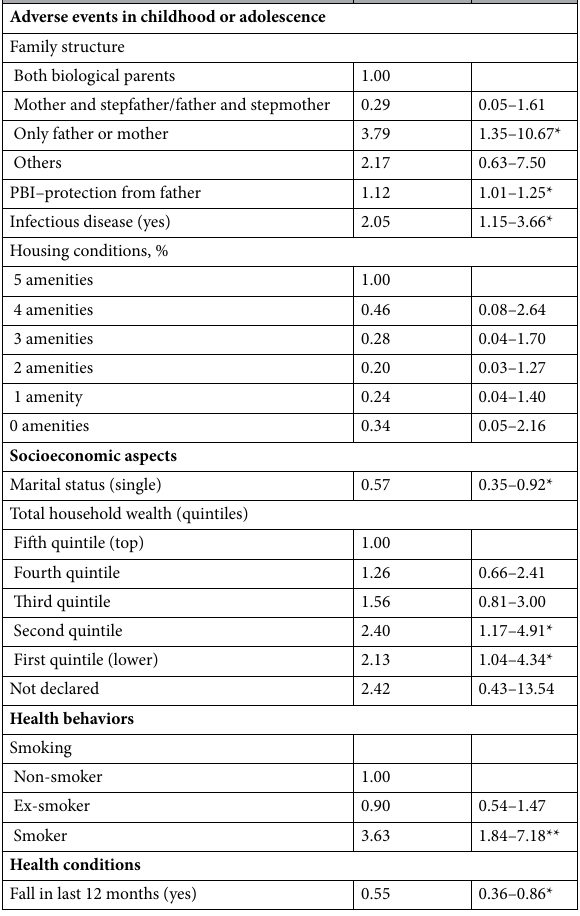
Table 5. Final model of factors associated with death before the age of 80 among men (n = 496) aged 50 years or older at baseline of ELSA study (2006) in 12-year follow-up period. OR odds ratio, CI confidence